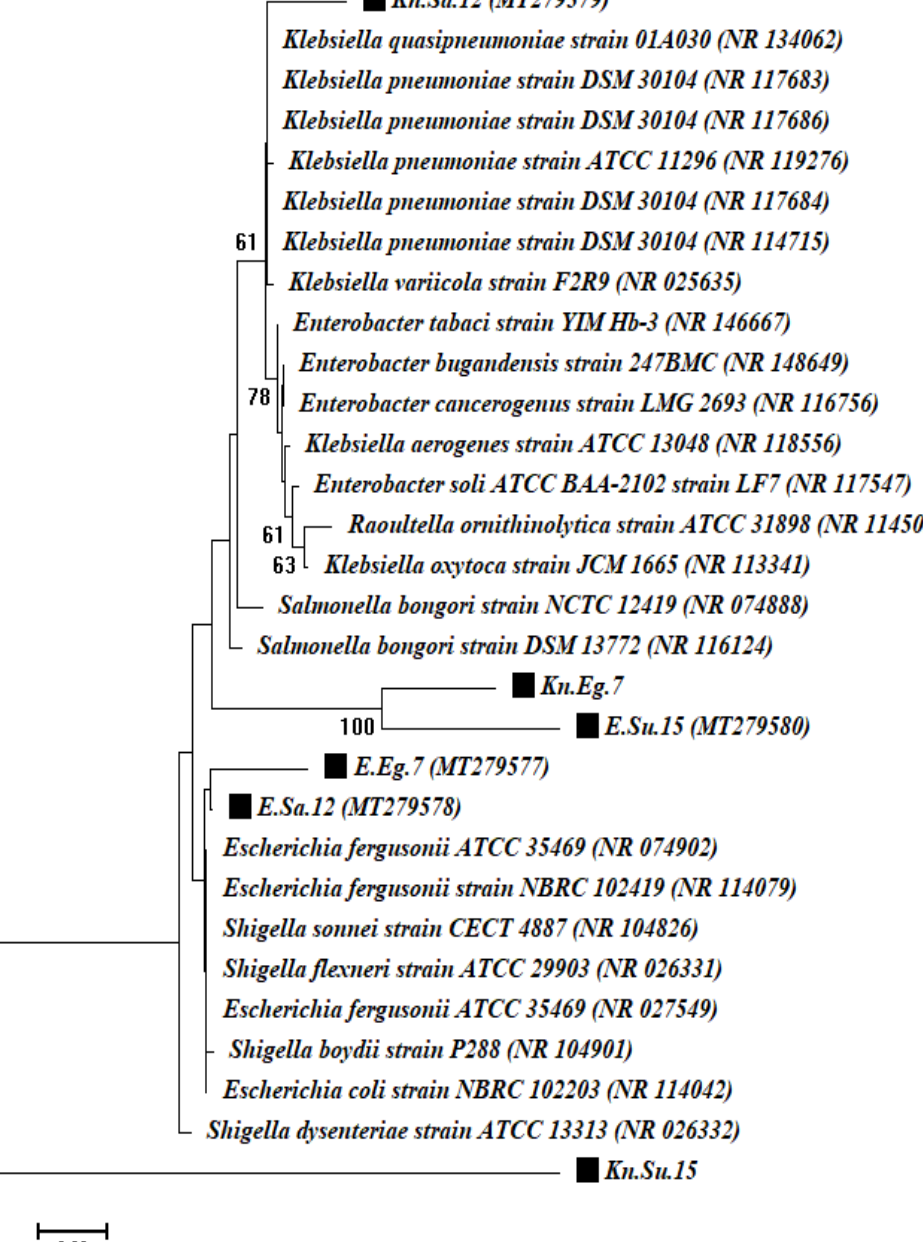
Figure 5. A phylogenetic tree based on 16S rRNA gene sequencing for the Escherichia coli , Pseudomonas aeruginosa , and Klebsiella pneumoniae strains.